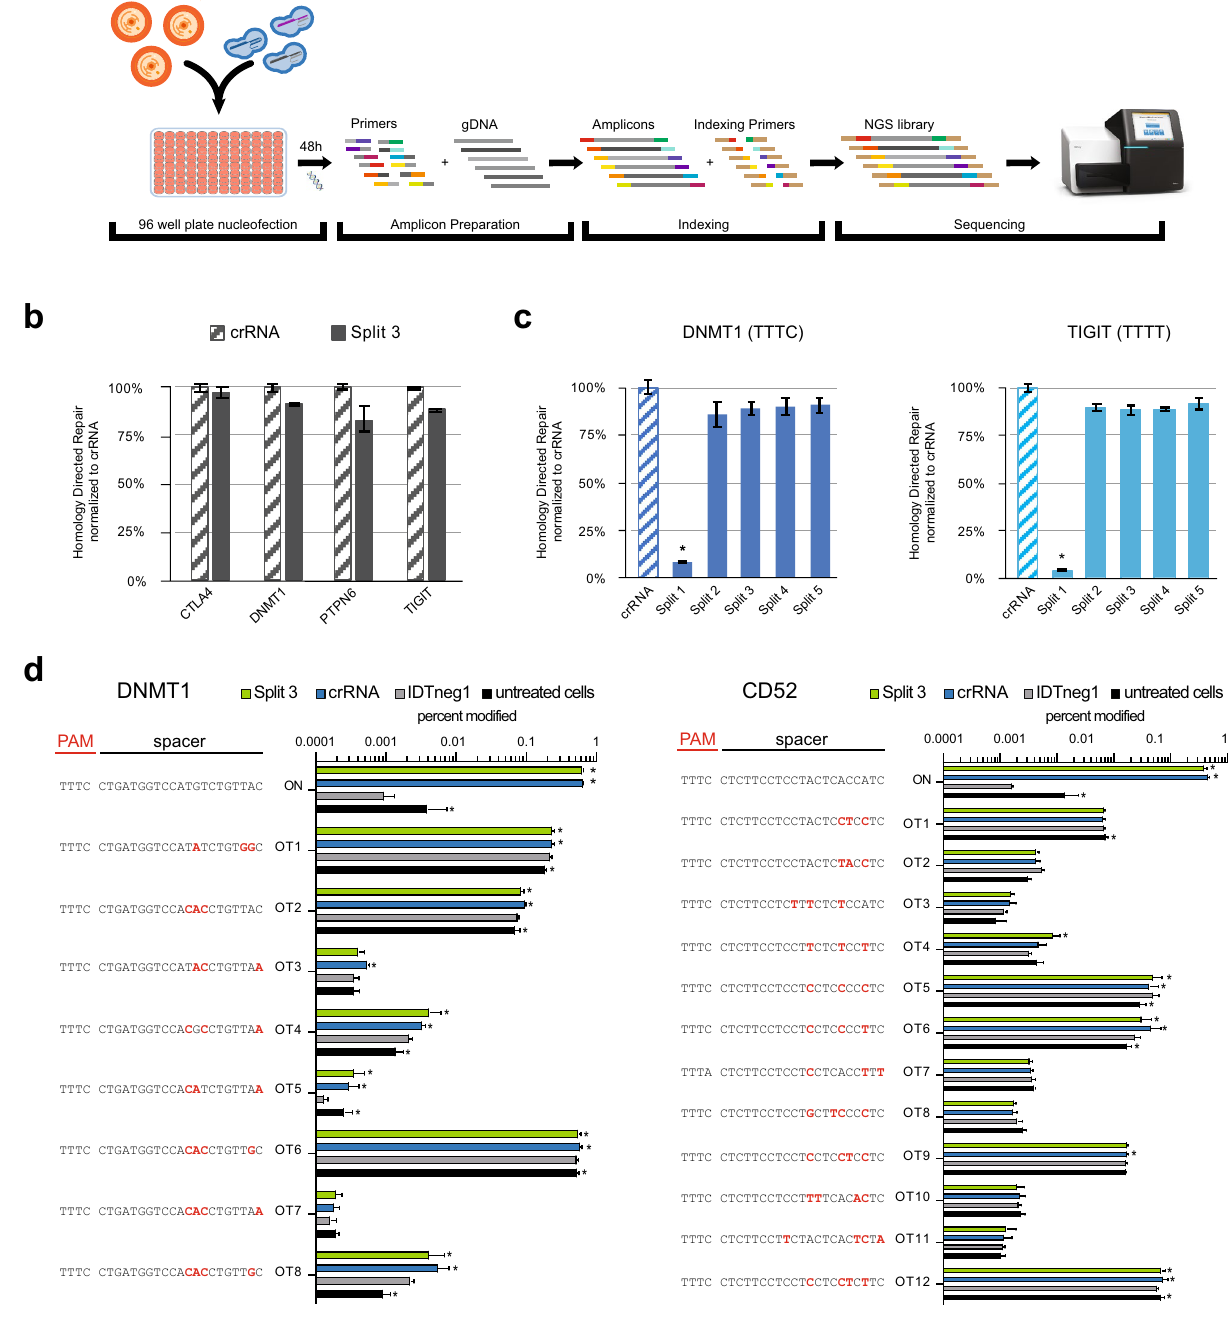
Figure 3. SynThetic trAcer RNAs (STARs) supporting human-cell engineering. ( a ) Schematic representation of the genome editing workflow. ( b ) Successful Homology Directed Repair (HDR, %) of MAD7 with wild-type crRNA and Split 3 STAR-crRNA at the CTLA4, DNMT1, PTPN6, and TIGIT loci, measured by amplicon sequencing (error bars: mean ± SEM for n = 6). Unnormalized HDR (%) data are presented in Supplementary Fig. 3a. ( c ) Successful Homology Directed Repair (HDR, %) of MAD7 with wild-type crRNA and various Split STAR-crRNA targeting the DNMT1 and TIGIT loci, measured by amplicon sequencing (error bars: mean ± SEM for n = 6). Unnormalized HDR (%) data are presented in Supplementary Fig. 3b. ( d ) Off-target INDEL frequency analysis (%) of MAD7 with wild-type crRNA and Split 3 STAR-crRNA targeting the DNMT1 and CD52 loci, measured by amplicon sequencing (error bars: mean ± SEM for n ≥ 3). Wild-type crRNA and Split 3 STAR-crRNA generated significant INDEL modifications at twelve off-target sites ( P ≤ 0.05) relative to IDTneg1 crRNA. Hypothesis was tested using a two-sided Fisher exact test with pooled read counts. Panels b and c : Samples showing significant changes in INDEL frequencies compared to wild-type crRNA, P ≤ 0.05 using two-sided t -test after a global one-way analysis of variance (ANOVA), are indicated with asterisk. The sequences of all crRNAs used are listed in Supplementary Table